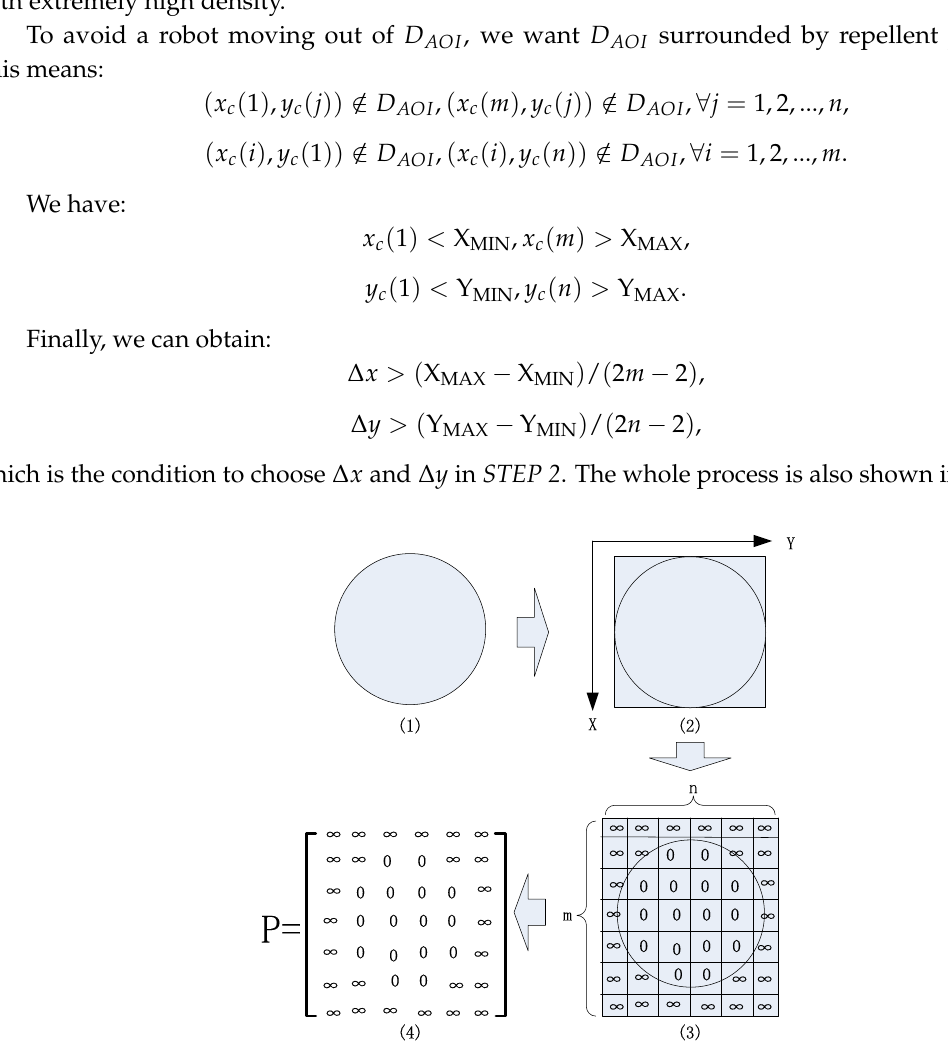
Figure 3. Mapping an AOI into a pheromone matrix. From (1) to (2), we find the MBR of the AOI. The definition of the coordinate system is also shown in (2). Then, the MBR is expanded slightly and scattered into m × n squares in (3). The cells that overlap with the AOI are set to 0, while other cells are set to ∞ . This manipulation ensures that, in the pheromone matrix, all inaccessible cells are filled with a repellent pheromone of extremely high density. Finally, we get the pheromone matrix P from these